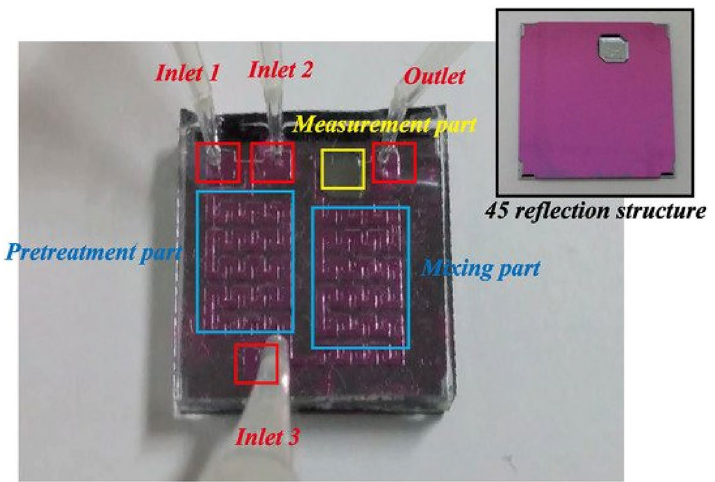
Figure 6. Saliva-based LOC biosensor 96